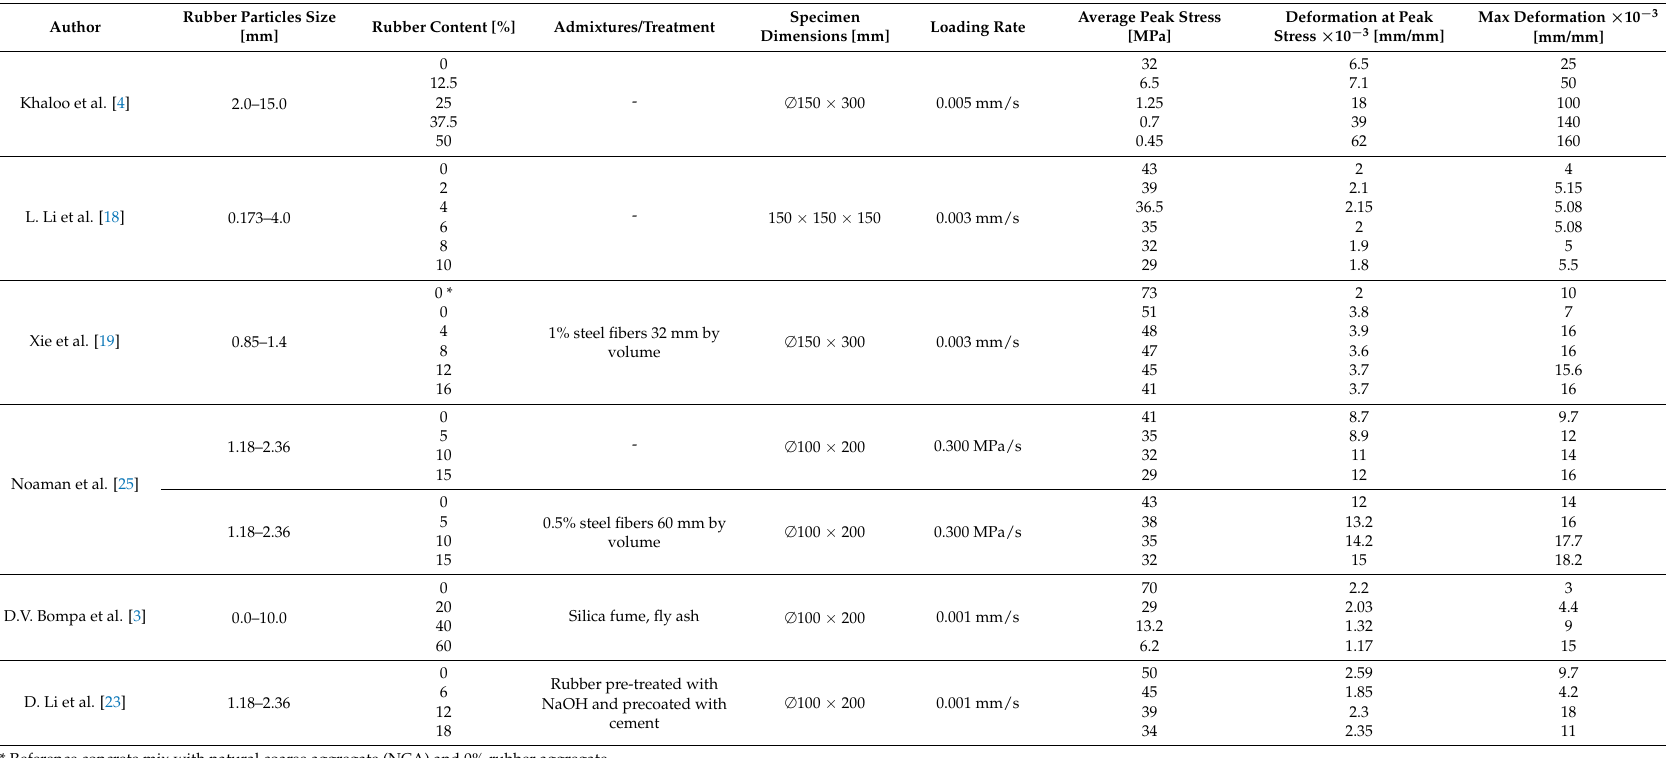
Table 1. Previous investigation on stress-strain behavior of rubberized